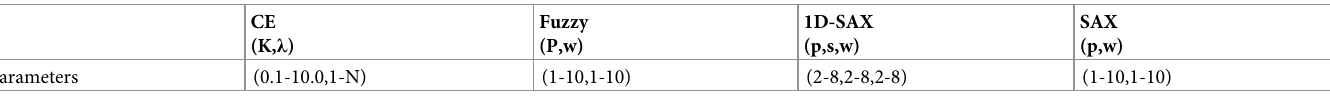
methods. As a final step an output file is also created. The output file shows the accuracy, the identified anomalous locations and the respective dates of the anomalies. Table 1. Ranges of parameters for